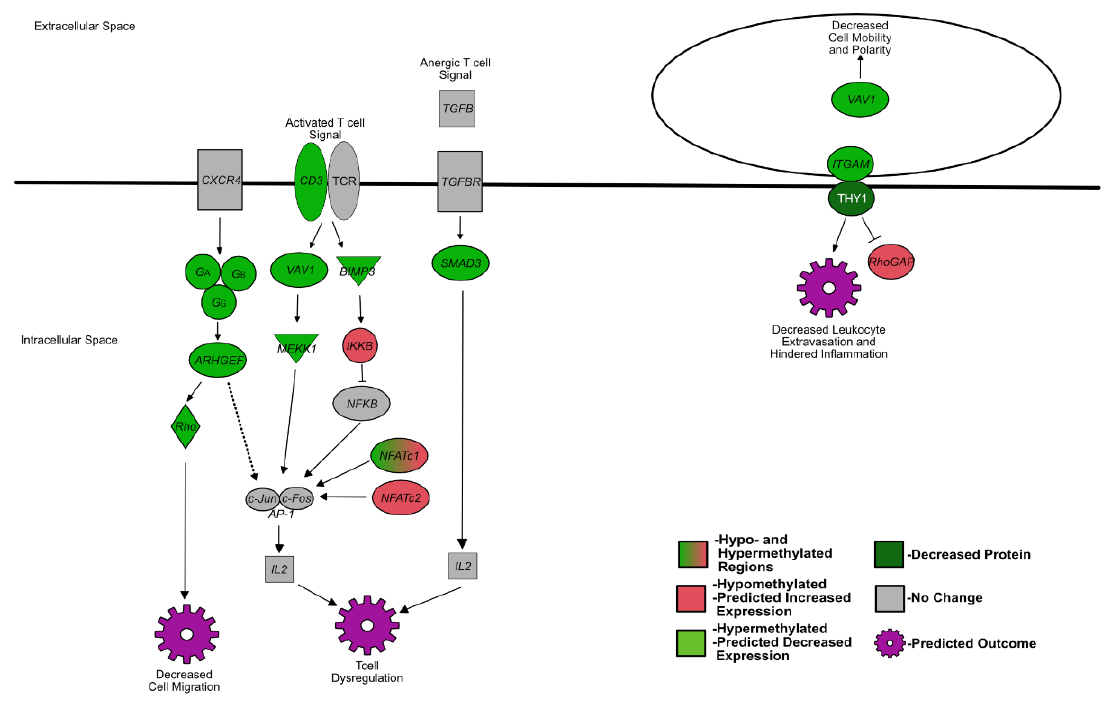
Figure 1. Summarized differentially methylated pathways and genes in PI fetal spleens associated with development of the fetal immune system. Green = hypermethylated, predicted decreased ex- pression; red = hypomethylated, predicted increased expression; gray = not differentially methylated or not identified in RRBS; white text = protein.